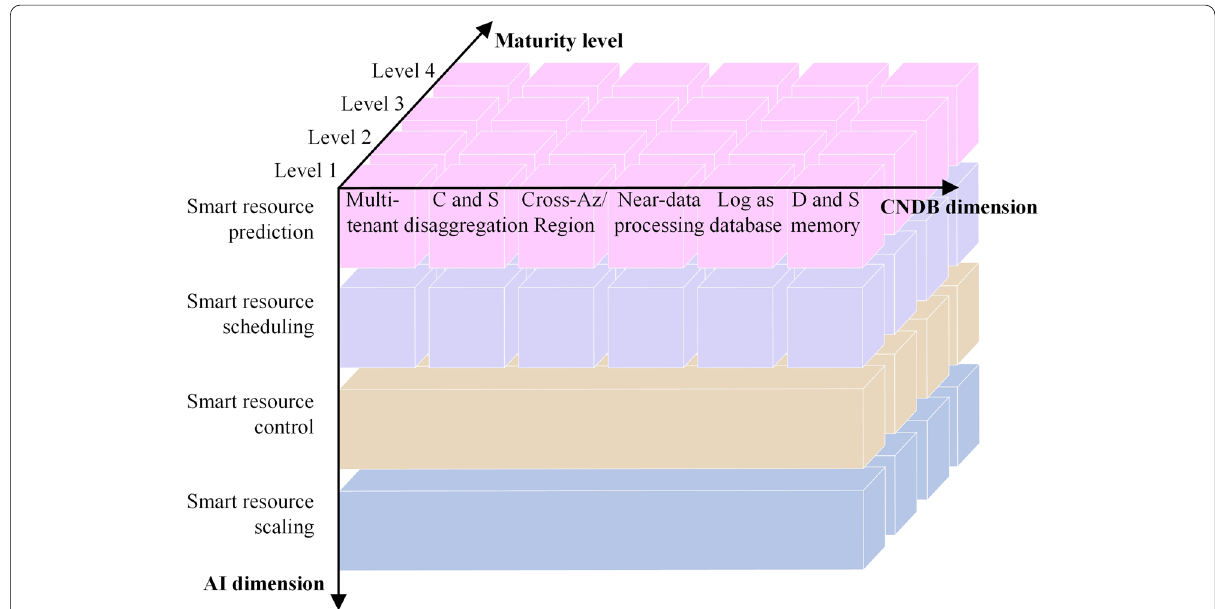
Fig. 3 Integrated maturity levels to indicator